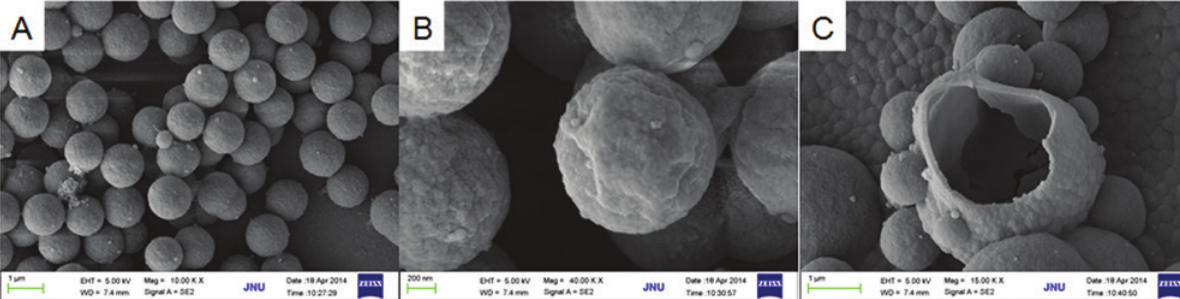
Figure 3: SEM images of nanocapsules (A, B) and (C) crushed.